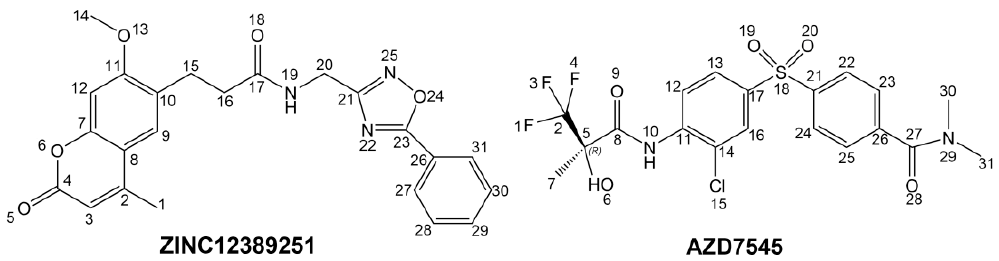
Figure 1. The structures of the novel compounds from virtual screening and the reference AZD7545.